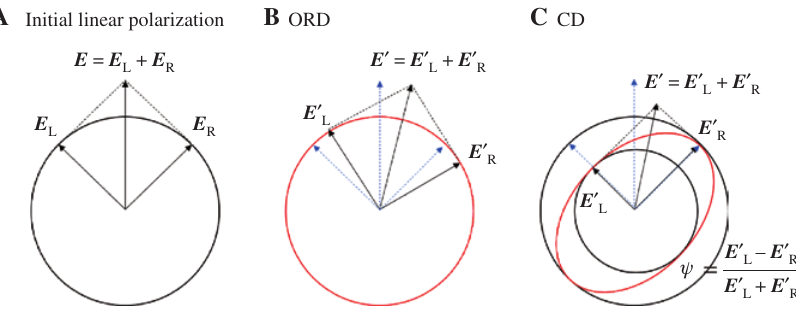
Figure 1: Schematic drawing of ORD and CD. (A) Initial electric field vector E of the beam before passing through the chiral sample. Final electric field vectors E ′ of the beams passing through two chiral samples with (B) ORD and (C) CD. Subscripts L and R, respectively, denote the left and right circularly polarized components of the field vector. The initial electric field components are indicated by blue arrows. The polarization ellipses of the final electric fields are depicted by red ellipse. The elliptical polarized beam experienced CD of the sample in Figure 1C can be characterized by - E + E the ellipticity ψ = ( E )/( E ), where the major and minor axes are given by E L R L R